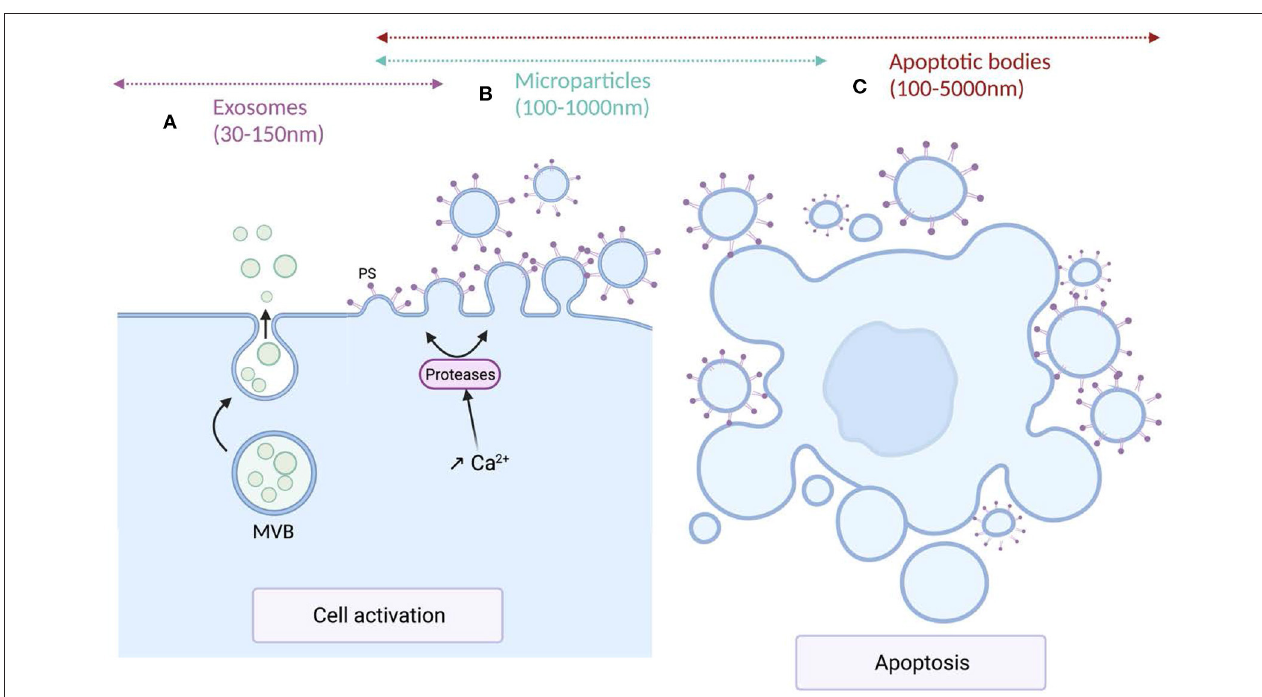
FIGURE 1 | Mechanisms of production and size of the different extracellular vesicles types. (A) Exosomes are formed within multivesicular bodies (MVBs) and released upon fusion of MVBs with plasma membrane. Exosomes (sEVs) exhibit a narrow diameter ranging between 30 and 150nm. (B) Microparticles (m/lEVs) diameter ranges from 100 to 1,000nm. MPs derive from the cytoplasmic membrane of activated or apoptotic cells. Cell activation induces an increase of intracellular Ca 2 + concentration leading to the translocation of phosphatidylserine (PS) to the outer leaflet of the cytoplasmic membrane and the activation of proteases that cleave the cytoskeleton, weaken its interaction with the cytoplasmic membrane, ultimately leading to the release of m/lEVs. (C) Apoptotic bodies are the largest EV subtypes exhibiting the wider size distribution (100–5,000nm). They result from cell fragmentation and decomposition of the cell membrane of apoptotic